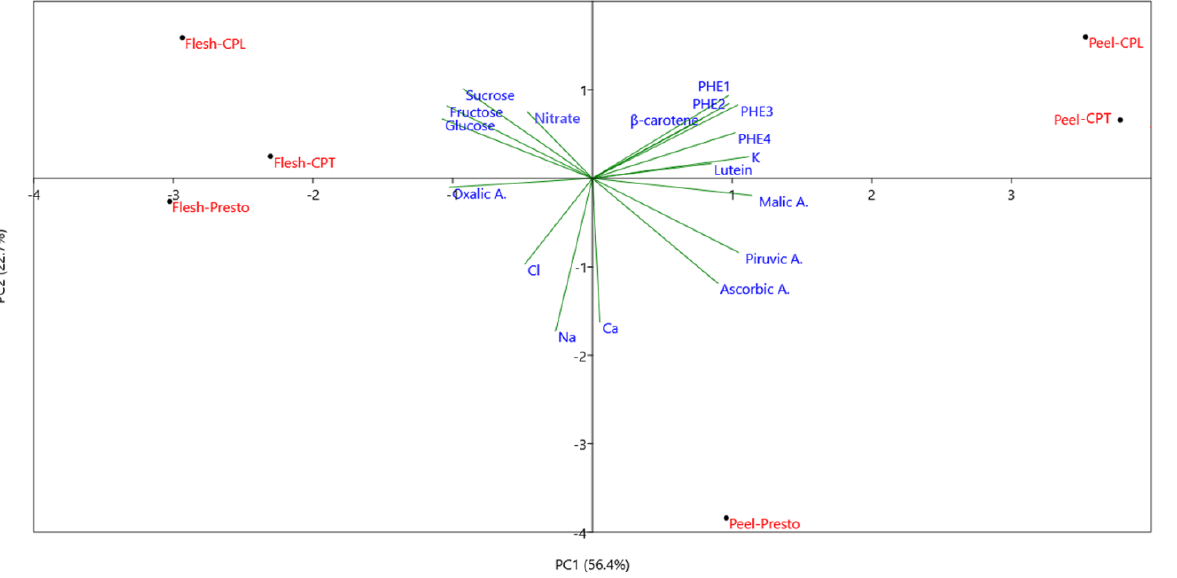
Figure 2. Principal Component Analysis bi-plot (PC1 vs. PC2) reporting the main chemical traits of carrots as affected by peeling and genotypes. The PHEx acronym indicates chlorogenic acid (PHE1), the di-caffeic acid derivative (PHE2), the caffeic acid derivate1 (PHE3), and 5-p-coumaroyl-quinic acid (PHE4). Please see Table 1 for the acronyms of carrot genotypes.